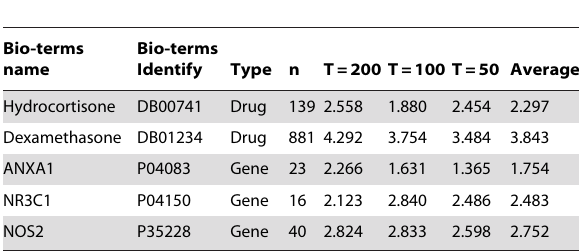
Table 9. Bio-term entropies for nodes shown in the top 3 paths.